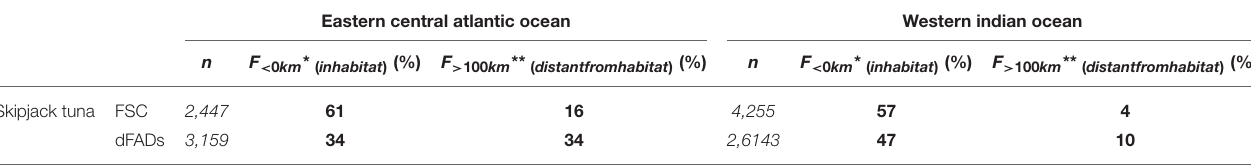
TABLE 2 | Proportion of presence data within favorable feeding habitat and more than 100 km away, by ocean basin and fishing mode